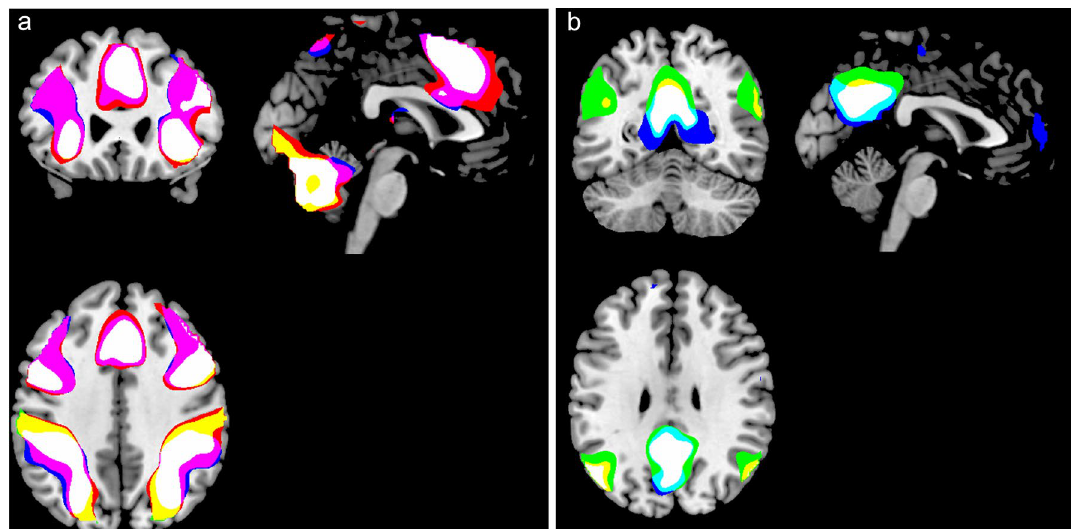
Figure 2. Activations for the three separate tasks overlaid on top of each other demonstrating significant overlap. The panel ( a ) to the left shows activations obtained during ON-blocks contrasted with activations obtained during OFF-blocks (ON–OFF). The panel ( b ) to the right shows activations obtained with the contrast flipped, i.e. obtained during OFF-blocks contrasted with activations obtained during ON-blocks (OFF–ON). For both panels ( a ) and ( b ), activation caused by the working memory task is shown in red, activation caused by the mental rotation task is shown in blue and activations caused by the mental arithmetic task is shown in green. Common activations across all three tasks are correspondingly indicated in white colour. Common activations for the mental rotation and working memory tasks are indicated in violet colour. Common activations for the mental rotation and mental arithmetic tasks are indicated in cyan colour, and common activations for the working memory and mental arithmetic tasks are indicated in yellow